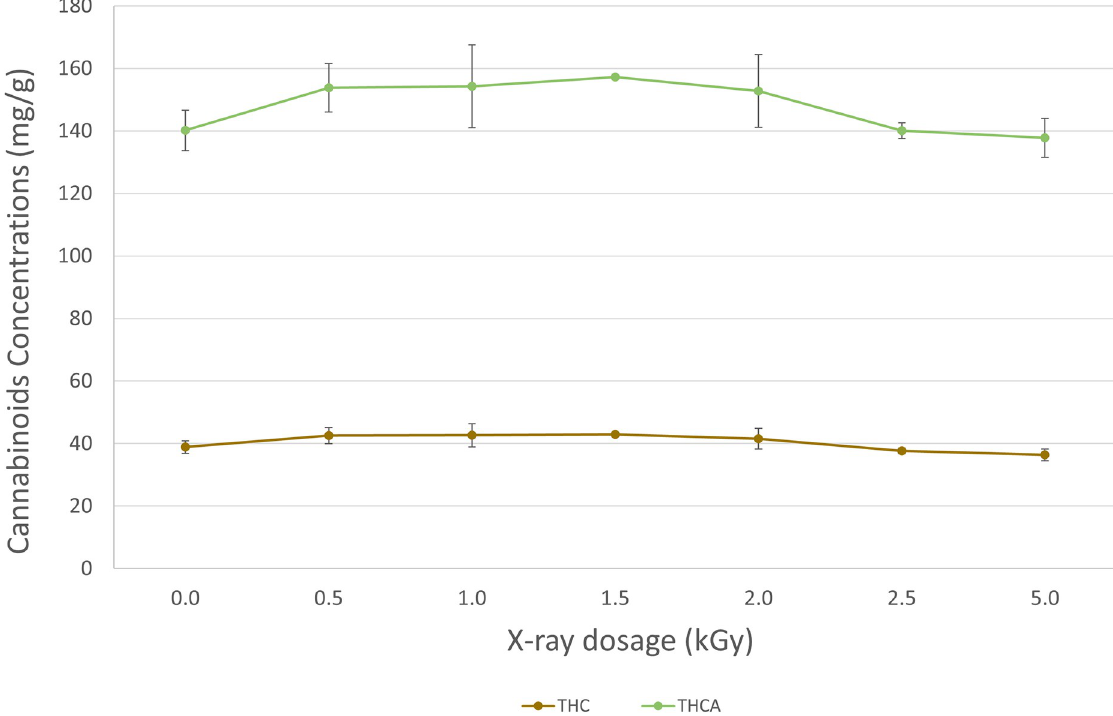
Fig 1. Cannabinoid concentrations in flower samples of untreated and treated at different X-ray irradiation dosage levels.